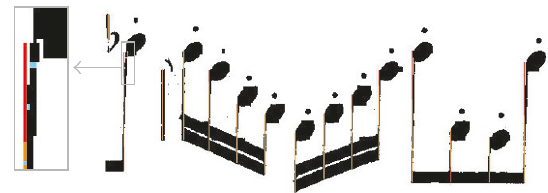
Figure 8: Vertical segment detection . In light blue the black pixels added through vertical closing, in orange the main black run and in red the run extensions corresponding to the merged black